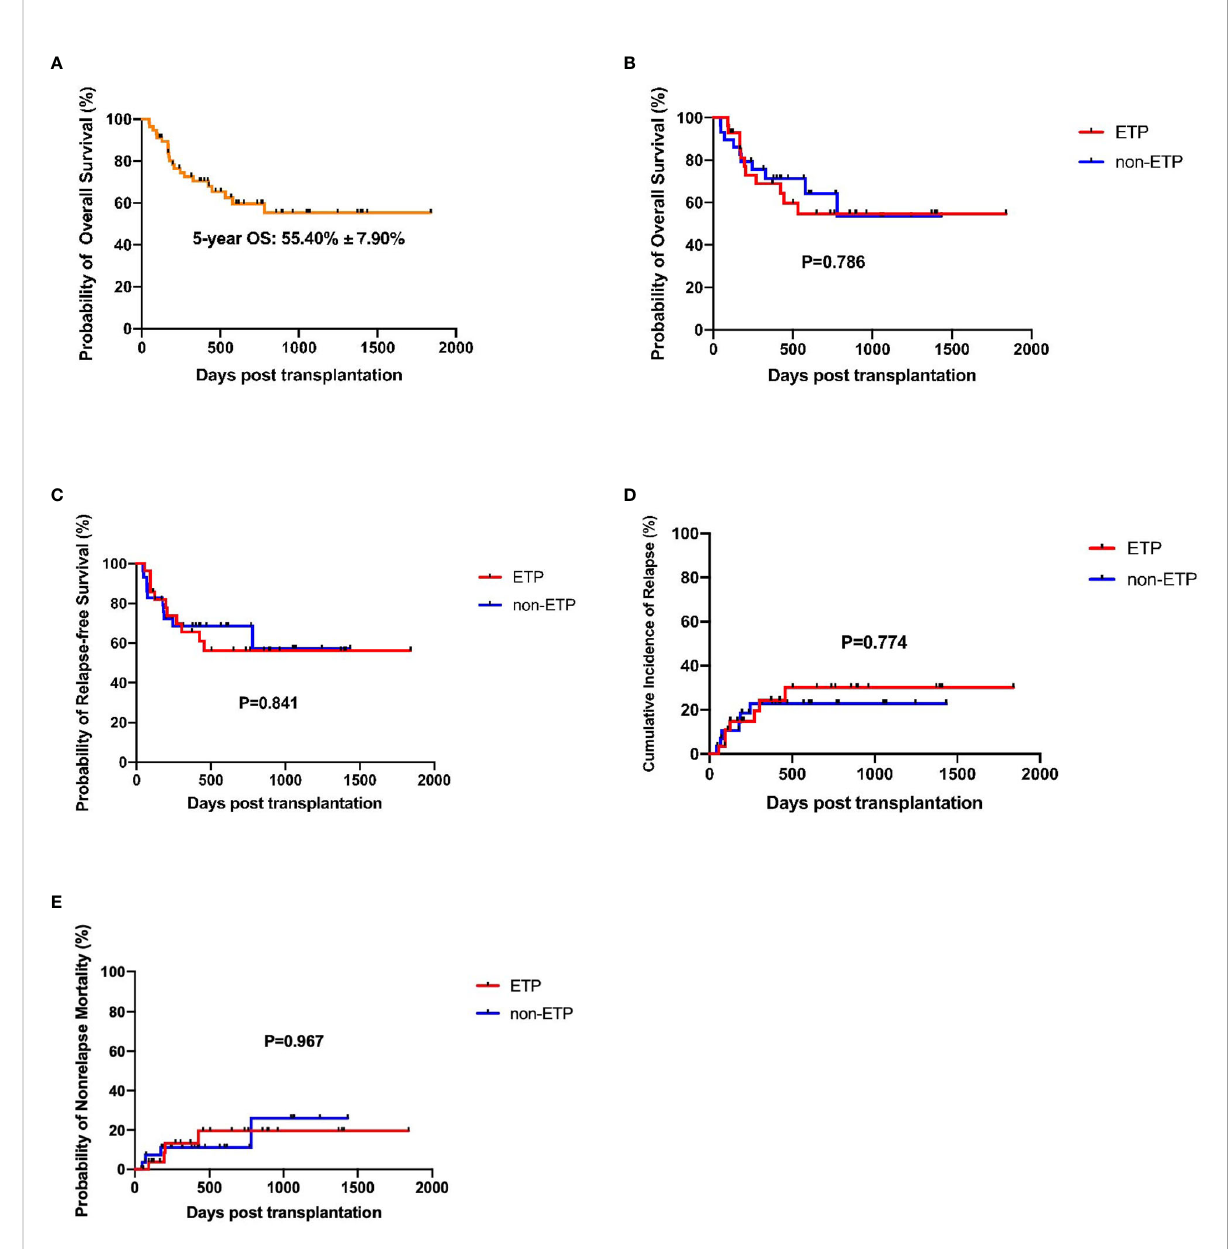
FIGURE 2 Survival analysis of early T-cell precursor (ETP) and non-ETP patients. (A) Overall survival of the total cohort; (B) Overall survival of ETP and non- ETP patients; (C) Relapse-free survival of ETP and non-ETP patients; (D) Cumulative incidence of relapse of ETP and non-ETP patients; (E) Non- relapse mortality of ETP and non-ETP